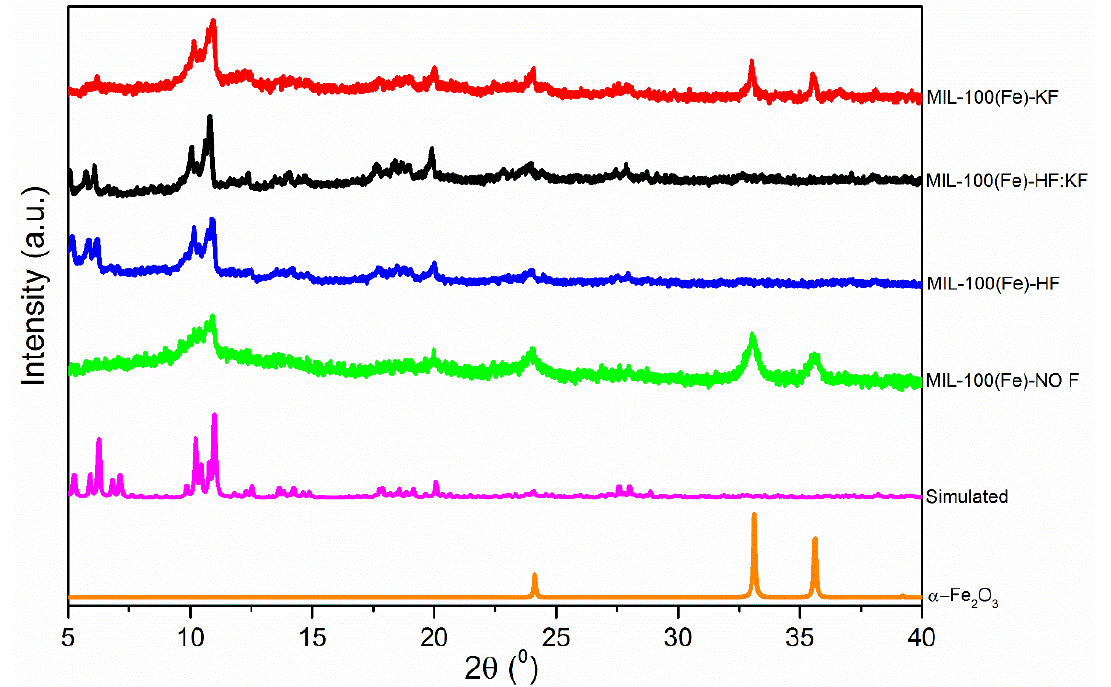
Figure 1. XRD pattern of the synthesized MIL-100(Fe) and simulated XRD pattern of MIL-100(Fe) (magenta) and α -Fe 2 O 3 .